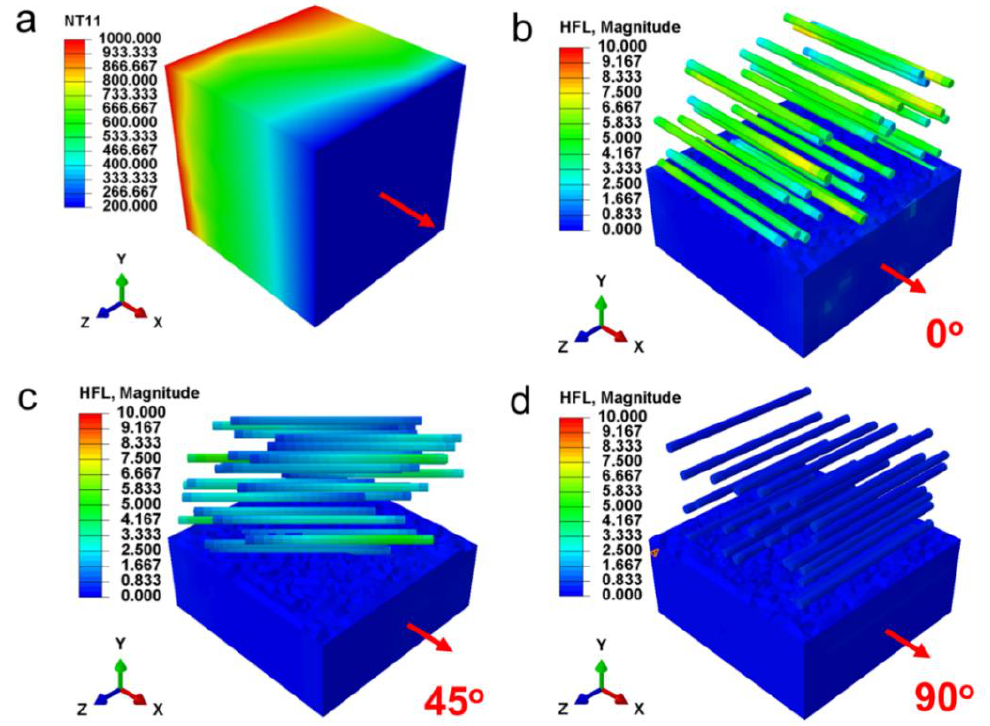
Figure 2. The heat conduction properties of ZrO 2 fibers network. ( a ) Temperature gradient vector of RVE. The angles between fiber axis and temperature gradient vector are ( b ) 0°, ( c ) 45° and ( d ) 90°.